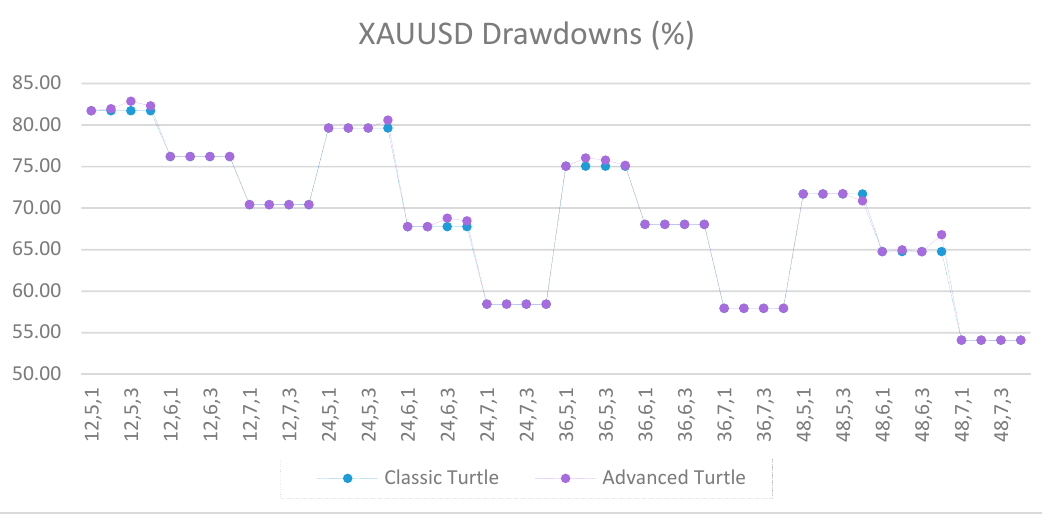
Figure A60. Drawdowns of XAUUSD as percentage of equity between the classic and the advanced Turtle systems for every combination of N, X, Y for the slow parameters (80, 160), where X ≥ 5.